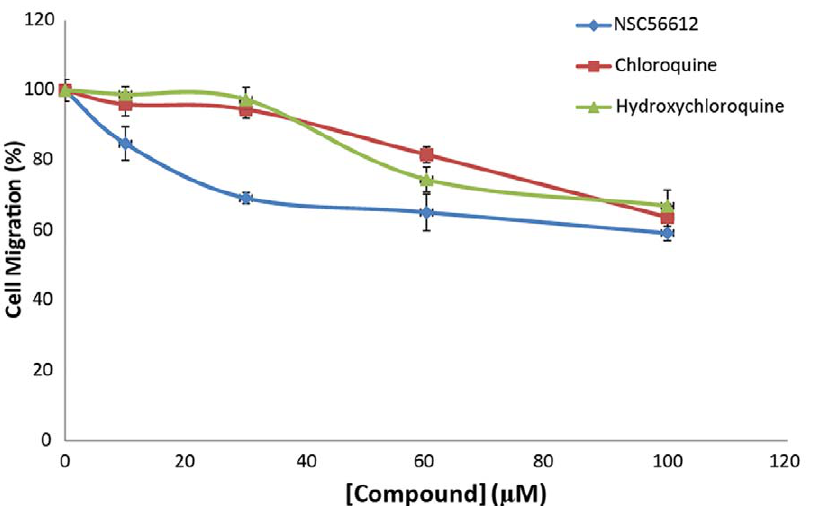
Figure 4. NSC56612, chloroquine, and hydroxychloroquine inhibit CXCL12-induced migration in a dose-dependent manner. Cells were plated in culture plates fitted with 8-uM pore membranes to create upper and lower cell culture chambers. Cells were plated in the upper chamber and CXCL12 (30 nM) alone or with the addition of NSC56612, chloroquine, or hydroxychloroquine was placed in the bottom chamber. The number of cells that migrated through the membrane in 5 hours was counted. Data shown is from 4 experiments performed in duplicate. Relative changes in cell migration are depicted with the control condition serving as 100% migration. Error bars represent 6 one SD. doi:10.1371/journal.pone.0031004.g004 terminus of the receptor; and aromatic residues Y45, W94, H113 and Y255 show favorable van der Waals interaction with the aromatic ring system in these compounds.